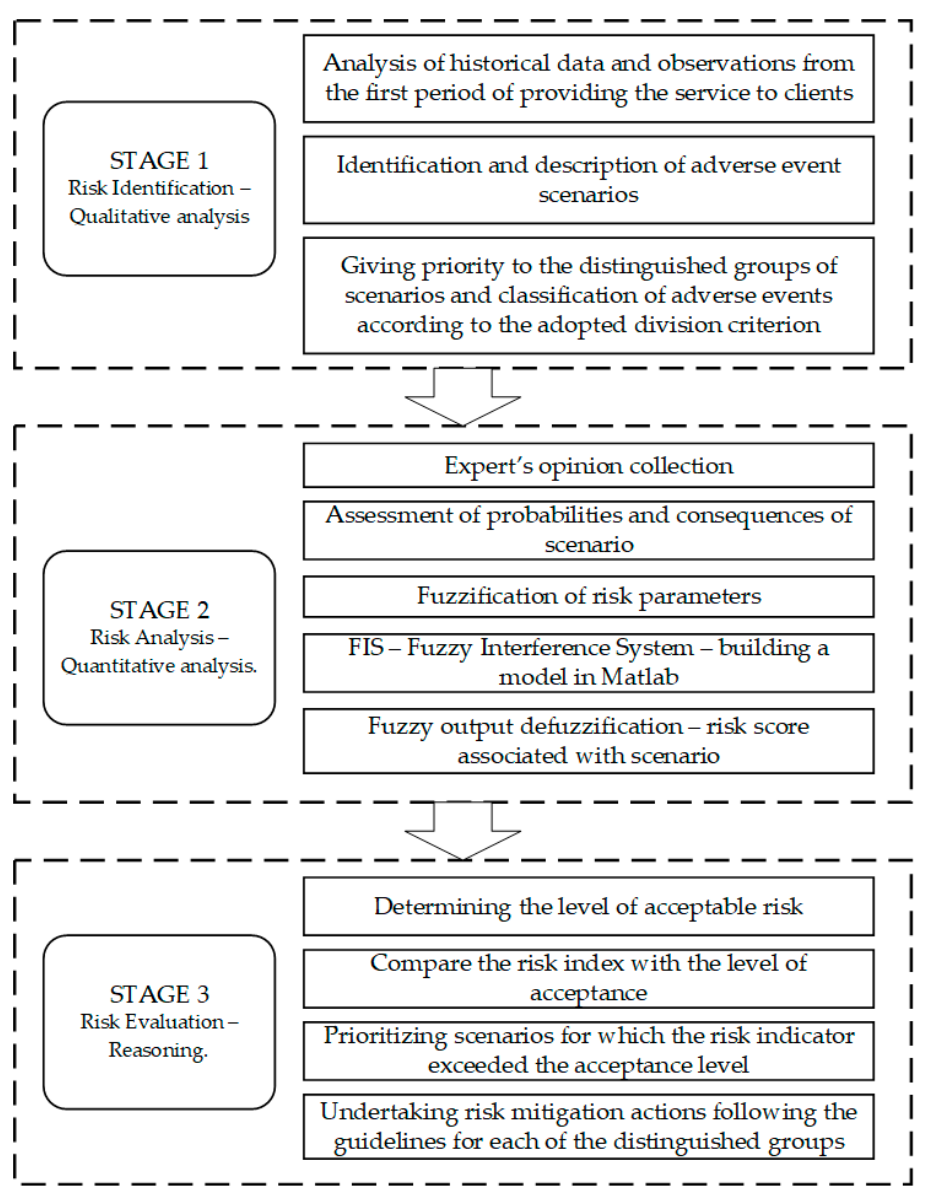
Figure 1. Procedure stages in risk assessment. Table 3. Priorities assigned to the distinguished groups of